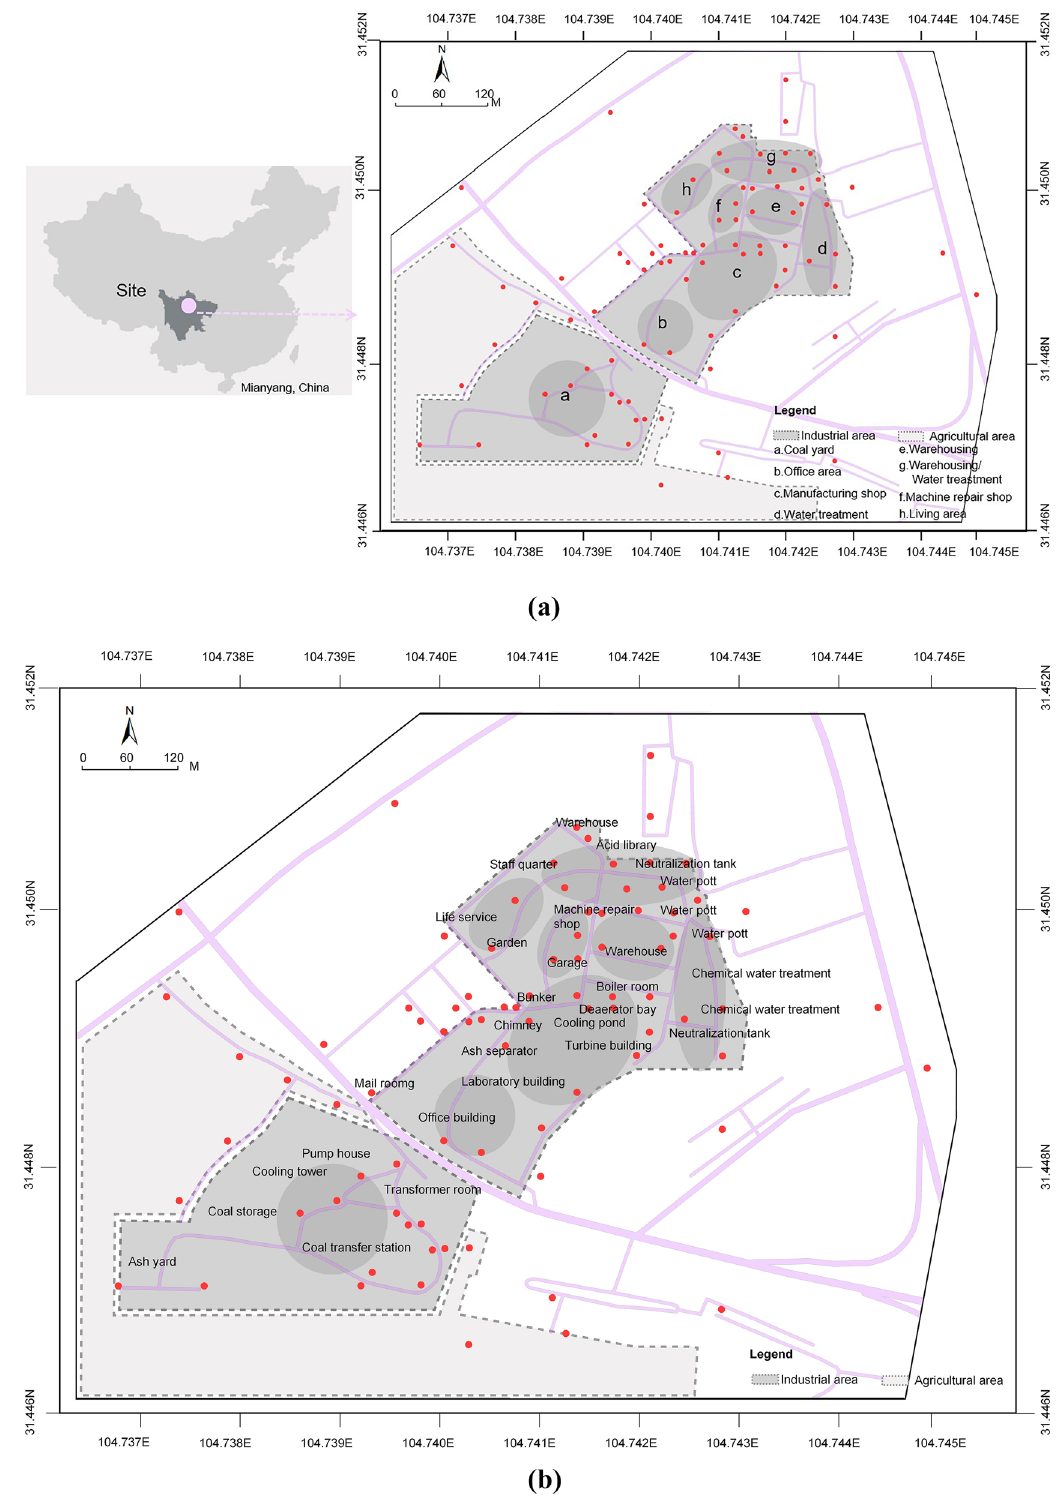
Figure 1. The study area: (a) Location of the study area; (b) Functional layout of the industrial area. (Note: The base map was designed by the author through referring to Baidu Map, https:// map. baidu. com and painting the City boundary and urban road network with Adobe Photoshop